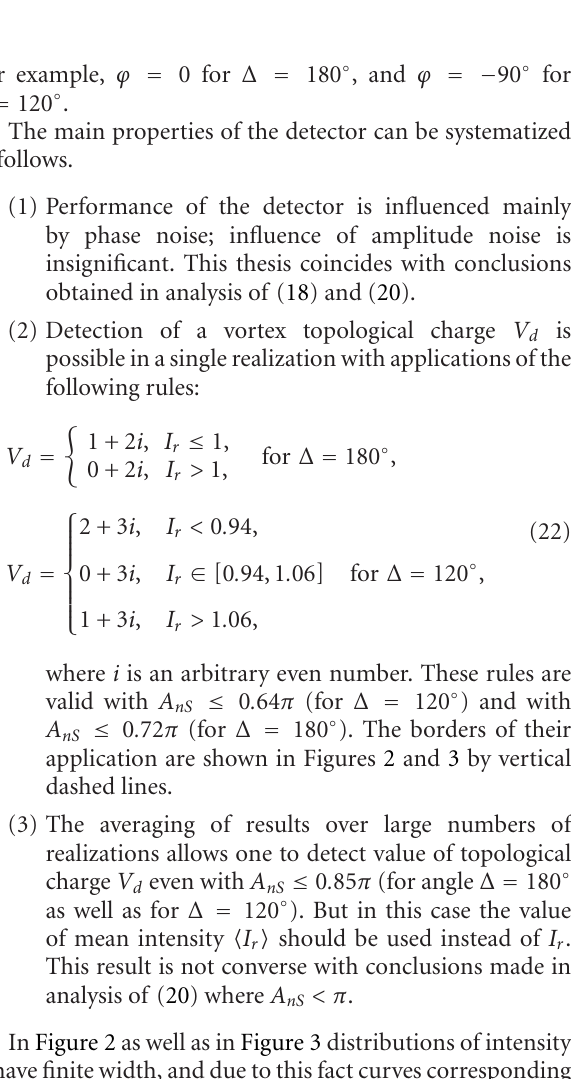
Figure 1: The modified Rozhdestvenskii interferometer as a de- tector of optical vortices. Rotation of rays 1, 2, and 3 is shown for the angle of 120 ◦